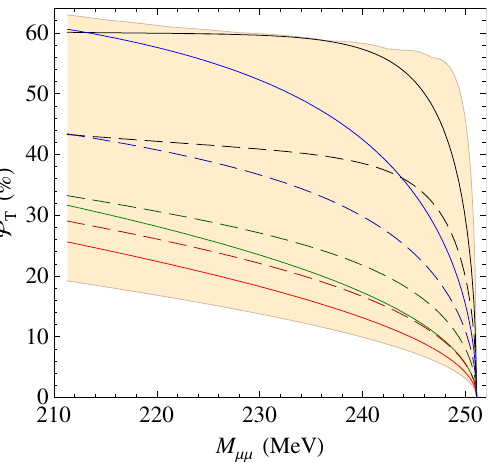
Figure 3 . The (cid:22) (cid:0) transverse-polarization asymmetry P (cid:0) SM. The light-orange (shaded) area represents the predicted range of P (cid:0) corresponding to those in (cid:12)gure 2 with the same curve